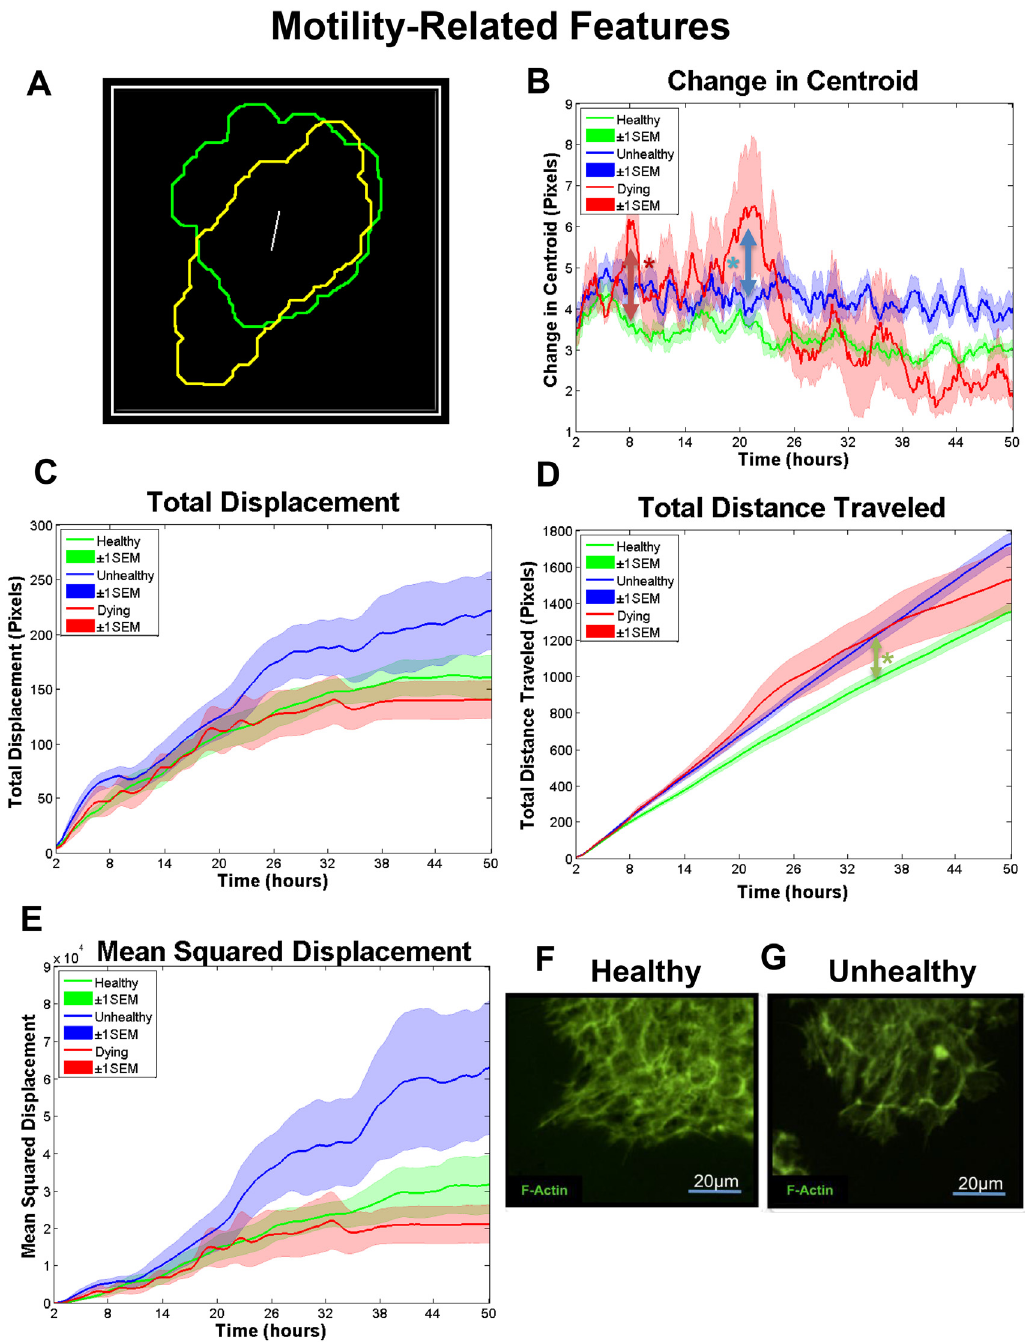
Fig 3. Features related to hESC colony motility. Extracted contour of a healthy colony at 16 hours (yellow line) and 24 (green line) hrs. The distance between the centroids is indicated by the white line. (B) Change in centroid over time for healthy, unhealthy, and dying colonies. Colonies first became significantly different by 2-way ANOVA at 7.7 hours for healthy versus dying groups (red arrow), and at 20.6 hours for unhealthy versus dying groups (blue arrow). (C) The total displacement for healthy, unhealthy, and dying colonies. (D) The total distance traveled for healthy, unhealthy, and dying colonies. Colonies first became significantly different by 2-way ANOVA at 34.7 hours for healthy versus unhealthy groups (green arrow). (E) The mean squared displacement (MSD) for healthy, unhealthy, and dying colonies. (F-G) Localization of actin microfilaments in a healthy (F) and an unhealthy (G) colony which had fewer microfilaments than the untreated control. Number of colonies per group = 16 healthy, 12 unhealthy, 6 dying. Data are plotted as means ± SEM for each group. Arrows indicate first values that differed significant from the control by 2-way ANOVA ( * = P < 0.05).